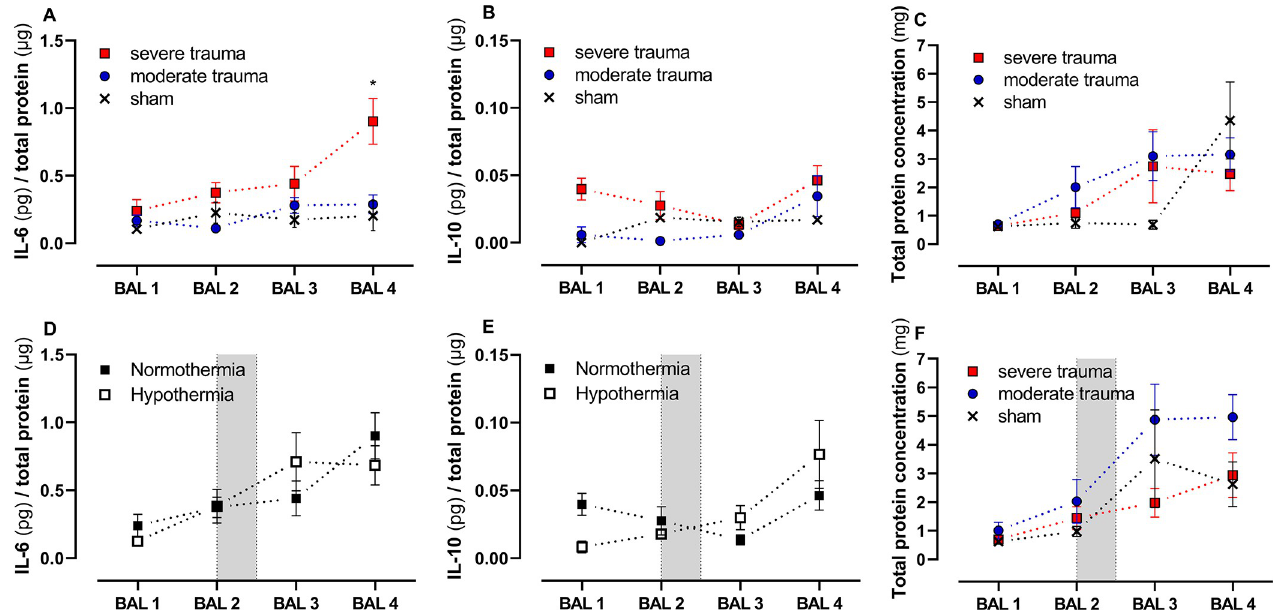
Fig 3. Time dependent activation of the pulmonary inflammatory response. Bronchoalveolar lavage fluid was sampled at four time points (before (BAL1) and after trauma (BAL2), after 24 (BAL3) and 48 hours (BAL4)), concentrated, and analyzed by ELISA. The mean values ± SEM are shown. Kinetics of IL-6 (A) and IL-10 (B) concentrations [pg cytokine/ μ g total protein] for sham, moderate trauma, and severe trauma and total protein (C; [mg]) under normothermic conditions over the course of the study period are shown. IL-6 concentration in BAL fluid increased significantly in the severe trauma group (p = 0.0373) over the course of 48 hours. Panel (D) and (E) depict kinetics of IL-6 and IL-10 concentrations of the severe trauma group comparing normo- and hypothermia treatment. The shaded area between BAL 2 and BAL 3 indicates the intervention with mild, controlled hypothermia over 12 hours. Figure (F) shows mean ± SEM total protein concentrations [mg] for sham, moderate trauma, and severe trauma with hypothermia treatment. Statistical analysis: Closed-testing principle of adjusted BAL4 values: Kruskal-Wallis (p � 0.05) and Wilcoxon-Mann-Whitney (p � 0.05) test. Detailed information including sample counts are provided in S2 and S3 Tables in S1 File